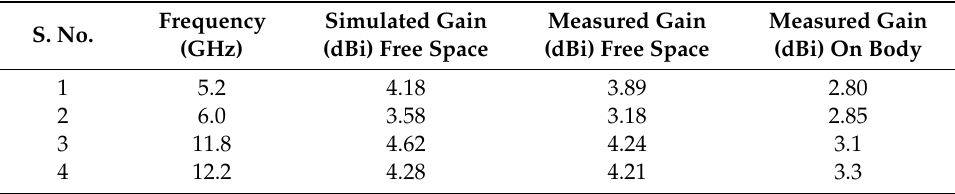
Table 2. Gain performance at di ff erent frequencies.